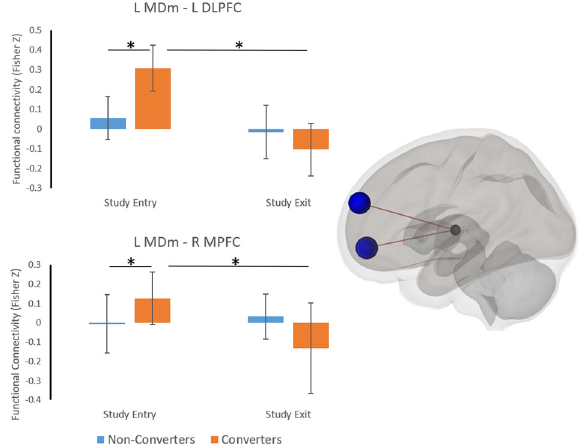
Fig. 5 Mediodorsal thalamus functional connectivity. Functional connectivity between left mediodorsal magnacellular (MDm) and left dorsolateral prefrontal cortex (DLPFC), and right medial prefrontal cortex (MPFC) is shown at study entry and exit. At study entry, coupling between the MDm and DLPFC and MPFC was stronger in converters compared to non-converters, however this showed a signi fi cantly greater decline over the two years. Error bars indicate sample standard deviations. * P-FDR <